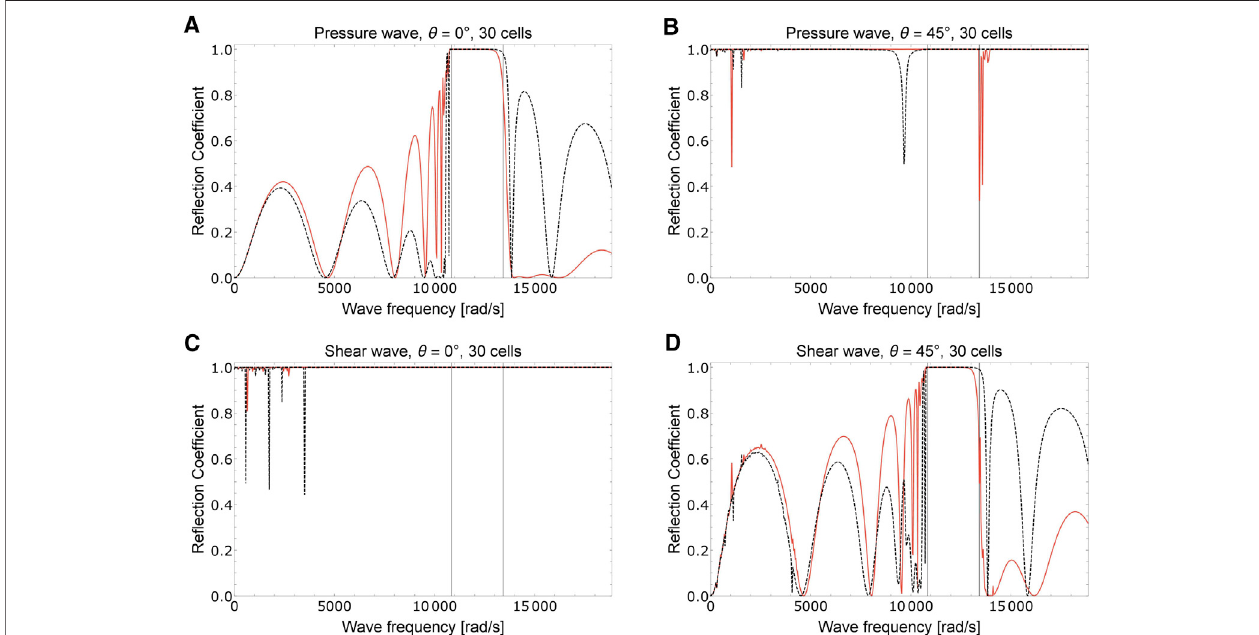
FIGURE 11 | Comparison of the microstructure ’ s (black line) and micromorphic (red line) re fl ection coef fi cient as a function of frequency for a 30 unit cells slab of MM1 and embedded in CM2 . (A) “ pressure ” normal incident wave with respect to the slab ’ s interface. (B) “ pressure ” 45 ° incident wave with respect to the slab ’ s interface. (C) “ shear ” incident wave normal to the slab ’ s interface. (D) “ shear ” 45 ° incident wave with respect to the slab ’ s interface.